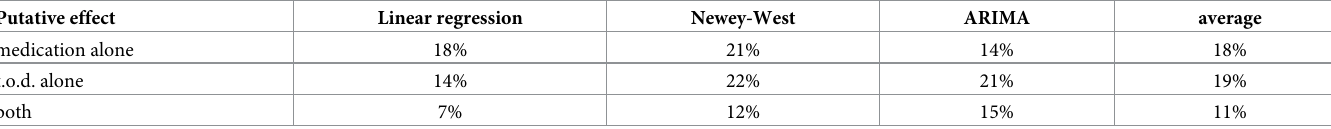
Table 3. Proportion of participants showing statistically significant putative effects, across the 3 distinct analysis approaches (after multiple testing correction). The abbreviation t.o.d. stands for time-of-the-day. The average column represents the average across the three methods. Putative effect Linear regression Newey-West ARIMA average medication alone 18% t.o.d.